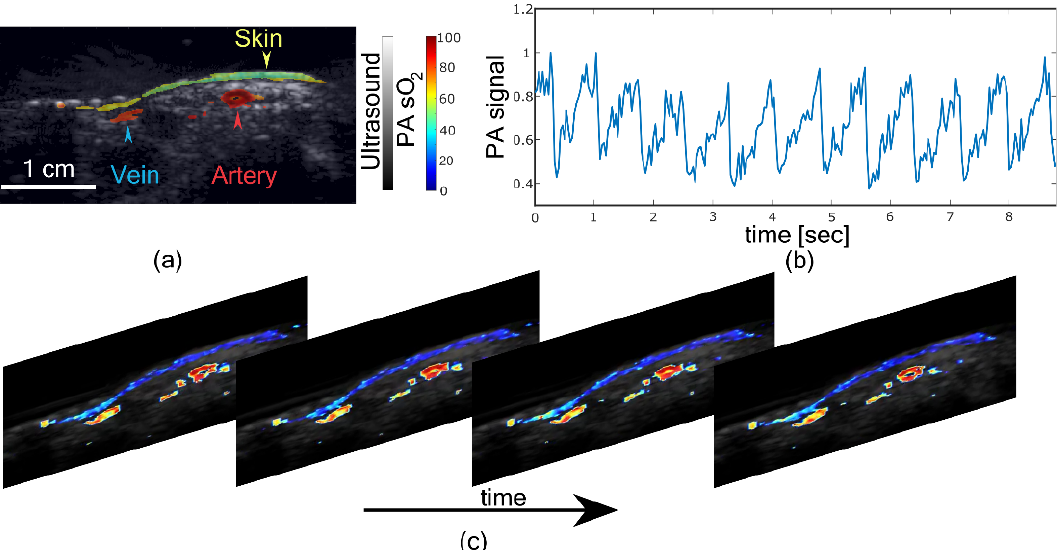
Figure 6. In vivo imaging on a human wrist. ( a ) Fluence compensated photoacoustic oxygen saturation (PA sO 2 ) image of the human wrist overlaid on an ultrasound image. ( b ) Normalized photoacoustic (PA) signal from artery showing pulsation. ( c ) PA sO 2 frames showing pulsating artery. (Video